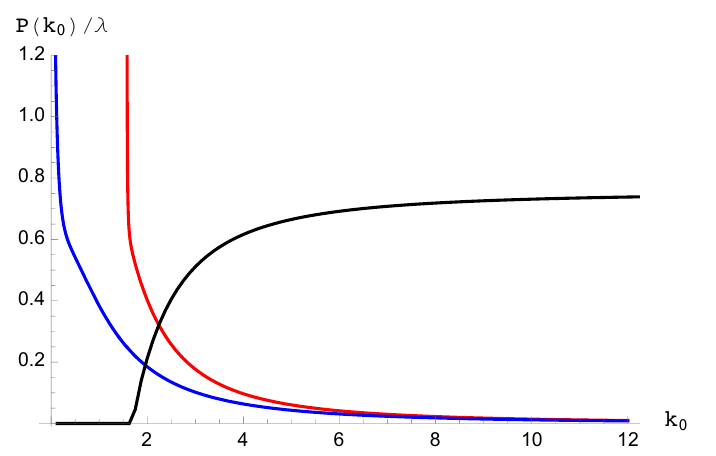
Figure 3 . The total probability of meson multiplication (black) from ref. [24], plotted against the probability of Stokes (red) and anti-Stokes (blue)